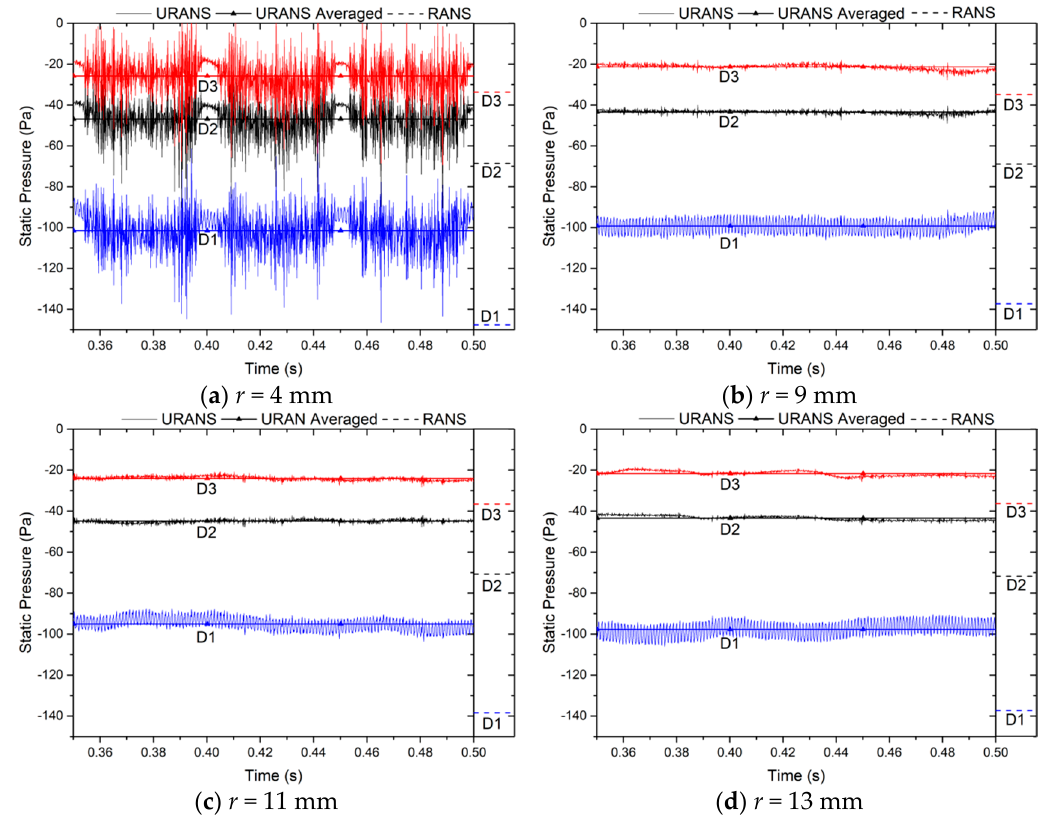
Figure 21. Static pressure fluctuation at monitors D1/D2/D3.